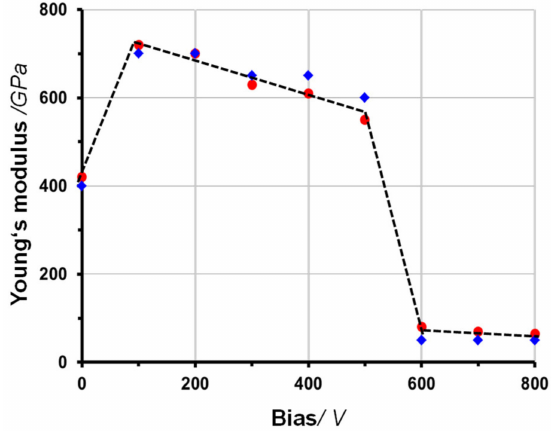
Figure 13. Dependence of the Young’s modulus on the bias voltage for filtered Laser-Arc deposition with grounded anode (data from [74]). red circles: direct determination by laser acoustics, blue diamonds: estimation from the XRR density in Figure 11 with Equation